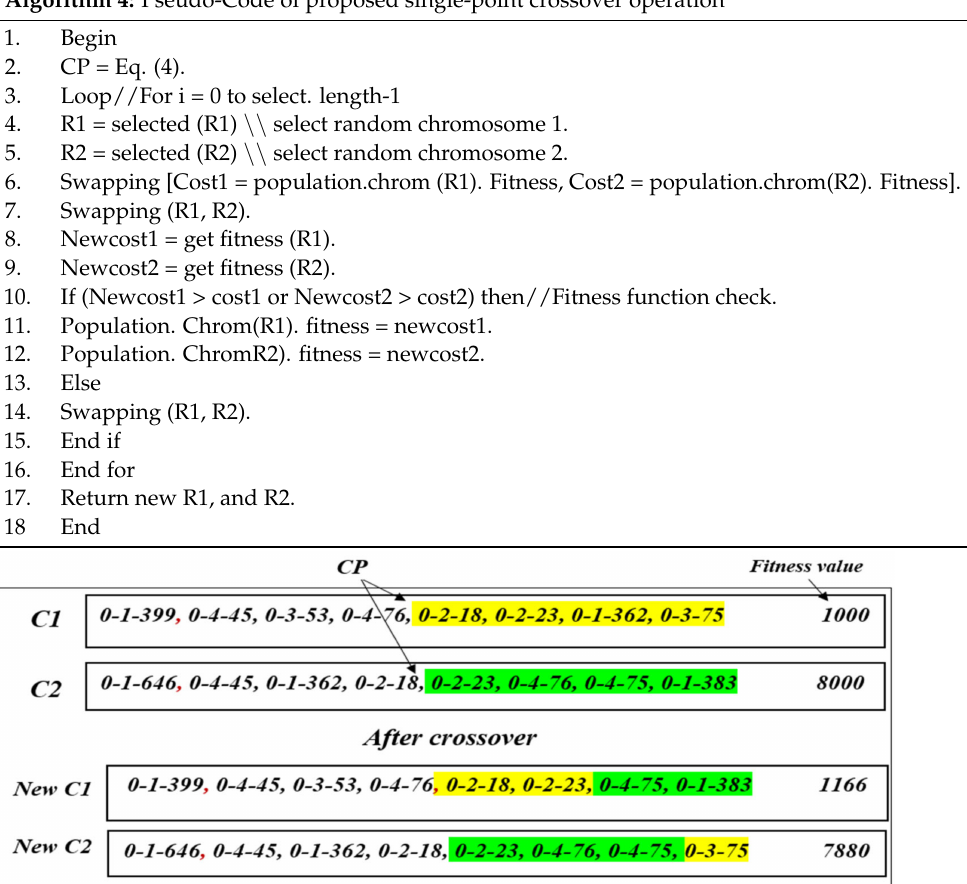
Algorithm 4: Pseudo-Code of proposed single-point crossover operation